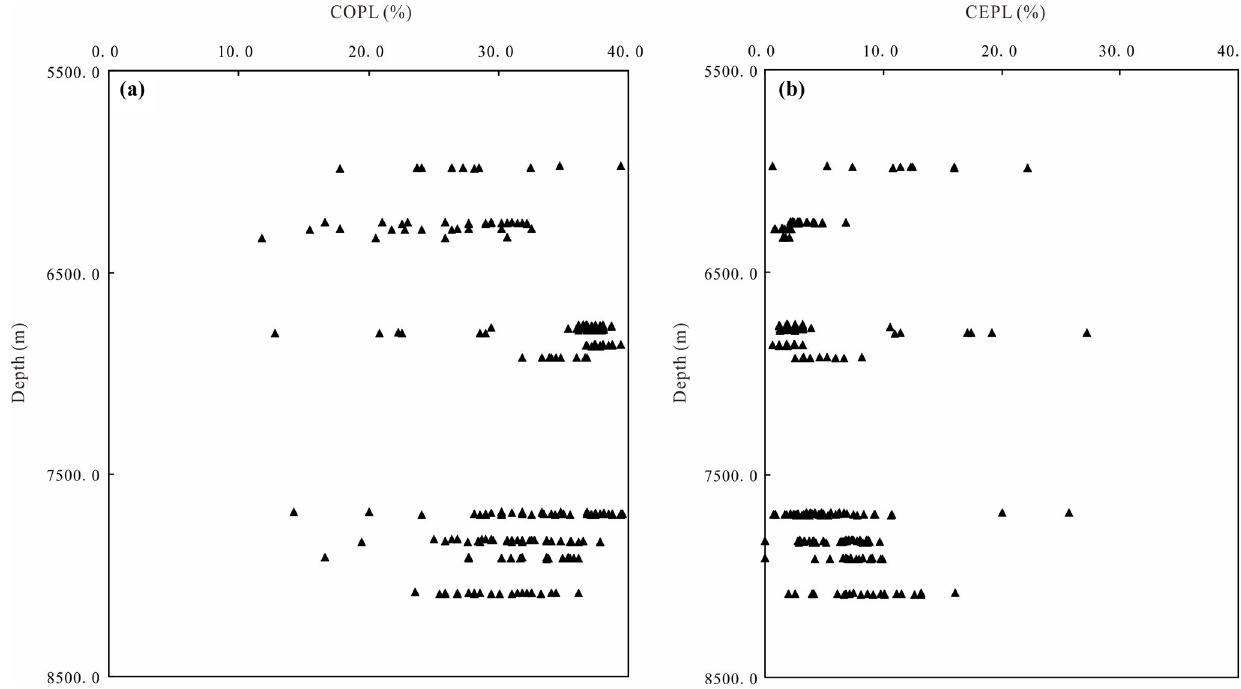
Figure 6. Plot of compactional porosity loss (COPL) and cementational porosity loss (CEPL) versus depth for the Bashijiqike sandstones. Table 1. Image-log-derived fracture parameters for Well Dabei 1101 in the Kuqa Depression. Strata Depth Open fractures Closed fractures Number intervals with fractures (m) Dip angles Average dip Dip angles Average dip Max Ave Max Ave Max